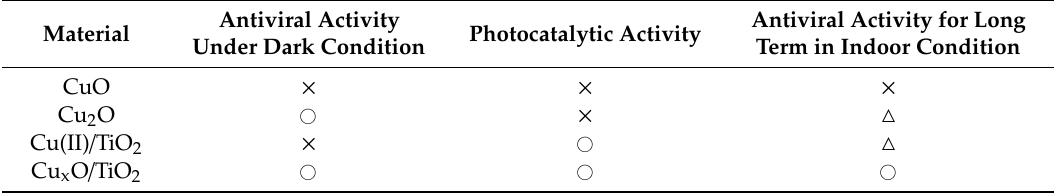
Table 1. The comparison of antiviral properties of various copper based compounds.